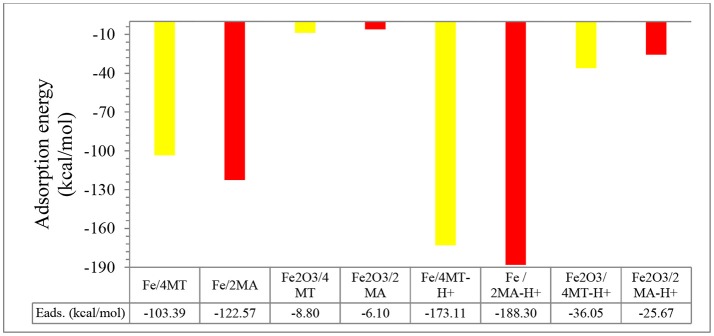
Adsorption energies for 2MA and 4MT (in neutral and protonated forms) onto Fe and Fe2O3 clusters.